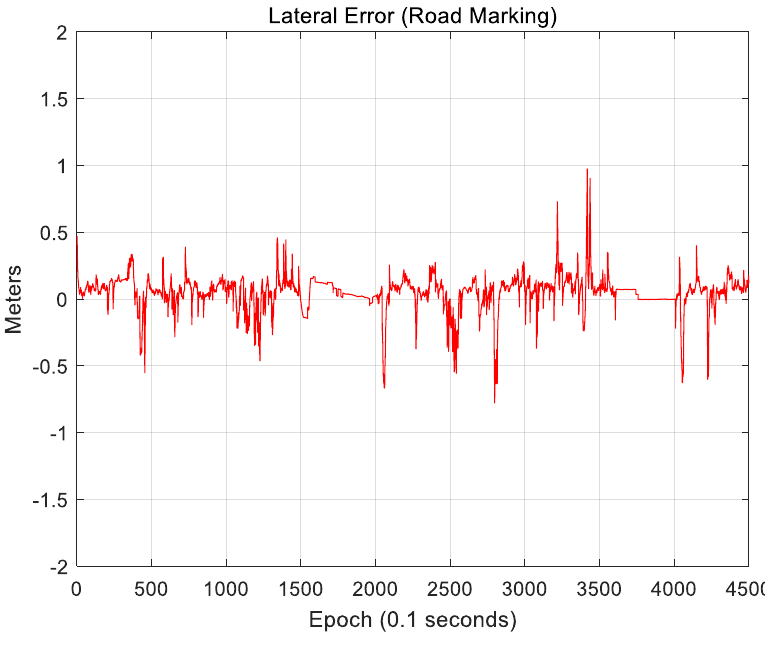
Figure 25. Lateral position error (road marking).